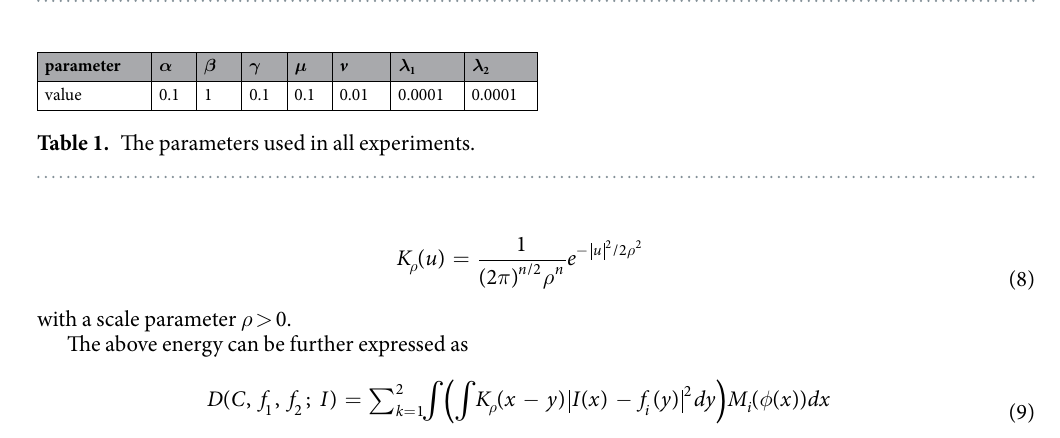
Figure 5. Box-plot of performance metric on the MICCAI dataset. The left column is left thalamus and the right column is right thalamus. The top row contains the similarity index, higher values implying greater volumetric overlap with the manual segmentation, and the bottom row contains the Hausdorff distance, lower values implying a surface closer to the manual